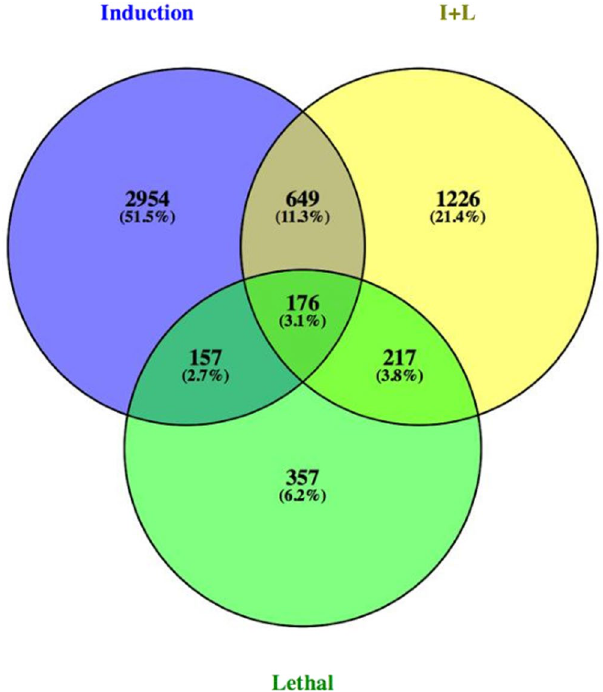
Figure 4. Venn diagram showing the number of overlapping transcripts that are differentially expressed under induction, I + L and lethal